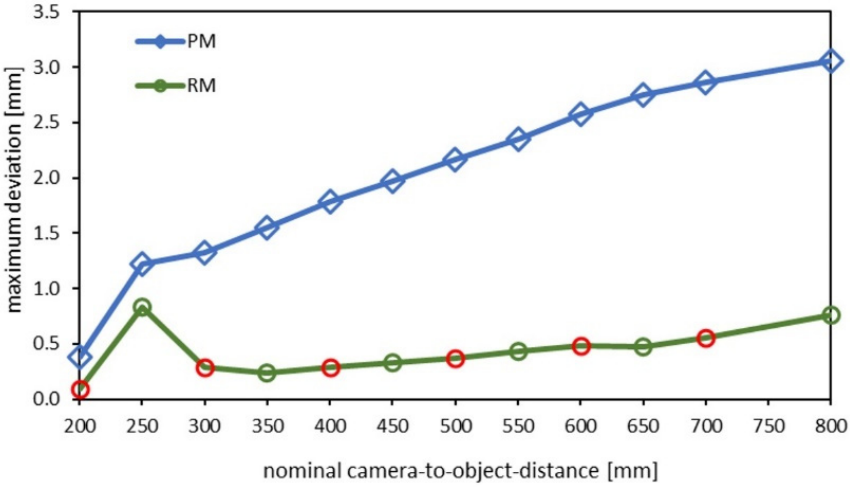
Figure 10. Flatness-deviation results. RM = ray-based calibration (green curve), PM = pinhole calibration (blue curve). Red circles mark the values used for refinement.